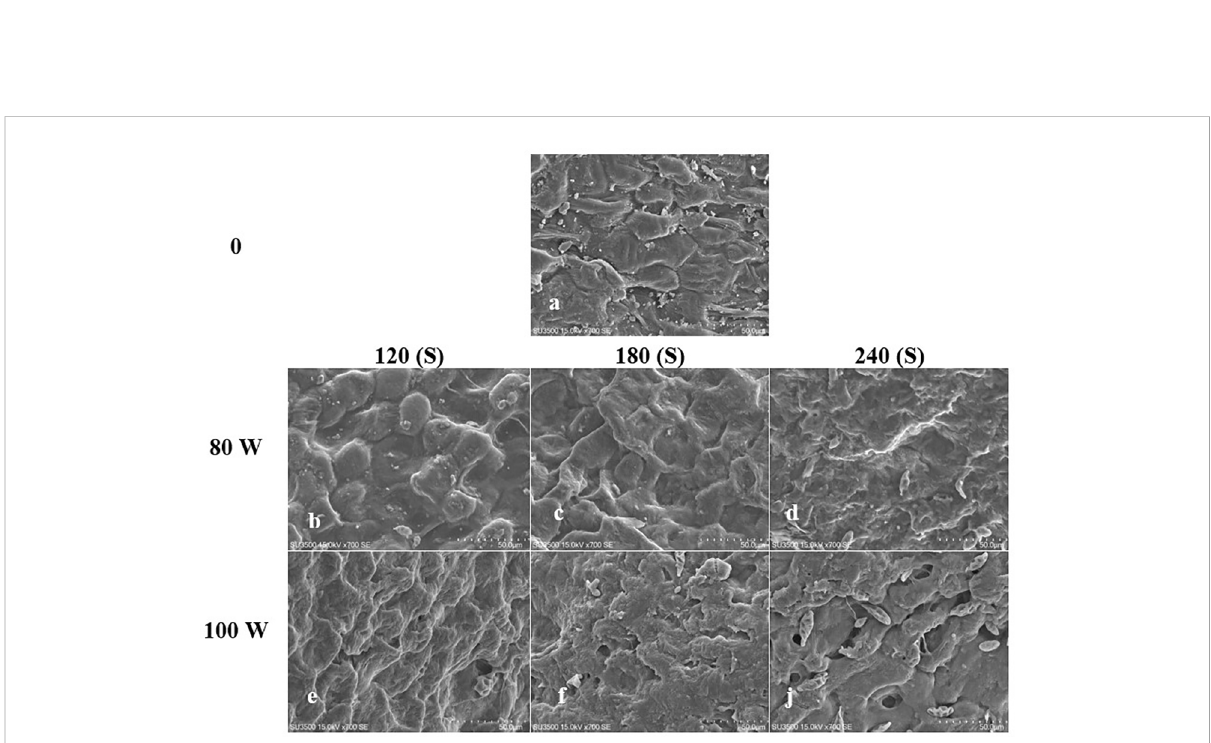
FIGURE 3 Scanning Electron Microscope (SEM) images of the hydro-primed normal seeds ONS) surface of S. leriifolia under cold plasma. (A) HNS, (B) HNS in 80 W 120s, (C) HNS in 100 W 120s, (D) HNS in 80 W 180* (E) HNS in 100 W 180s, (F) HNS in 80 W 240s, (J) in 100 W 240s.